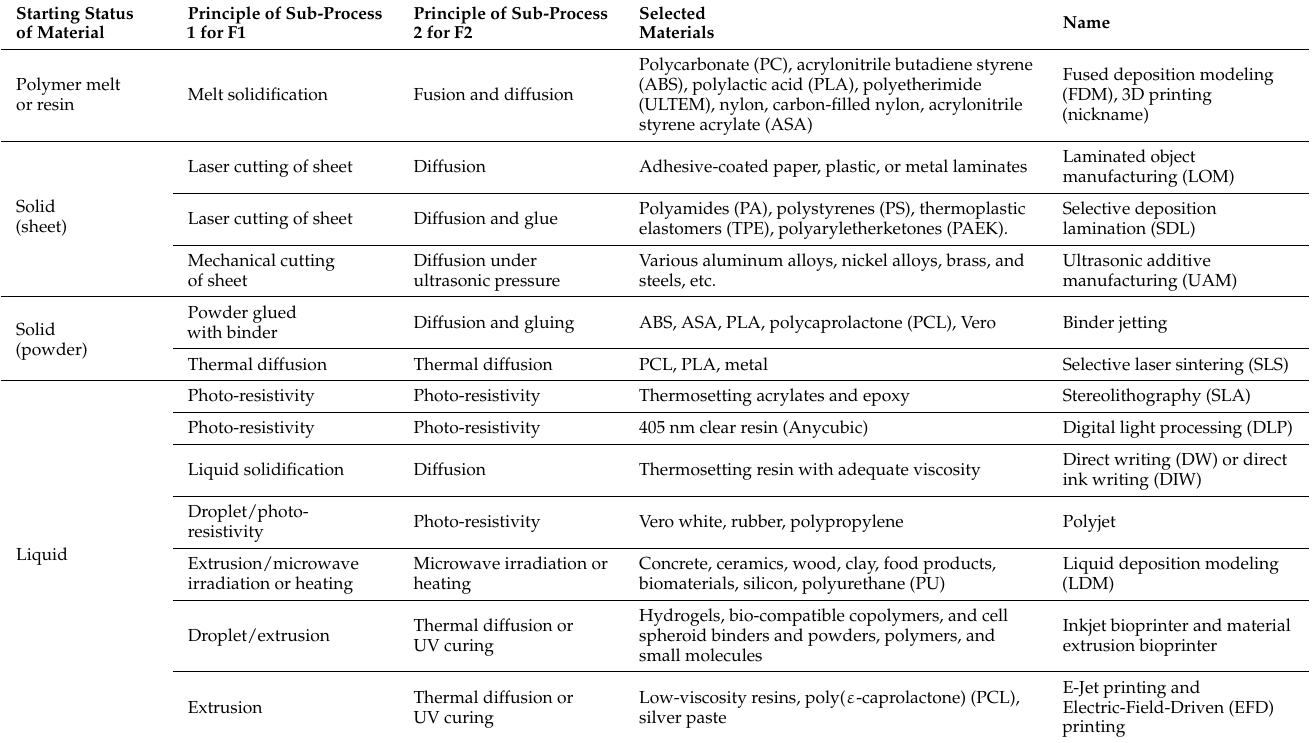
Table 1. Classification of the AM